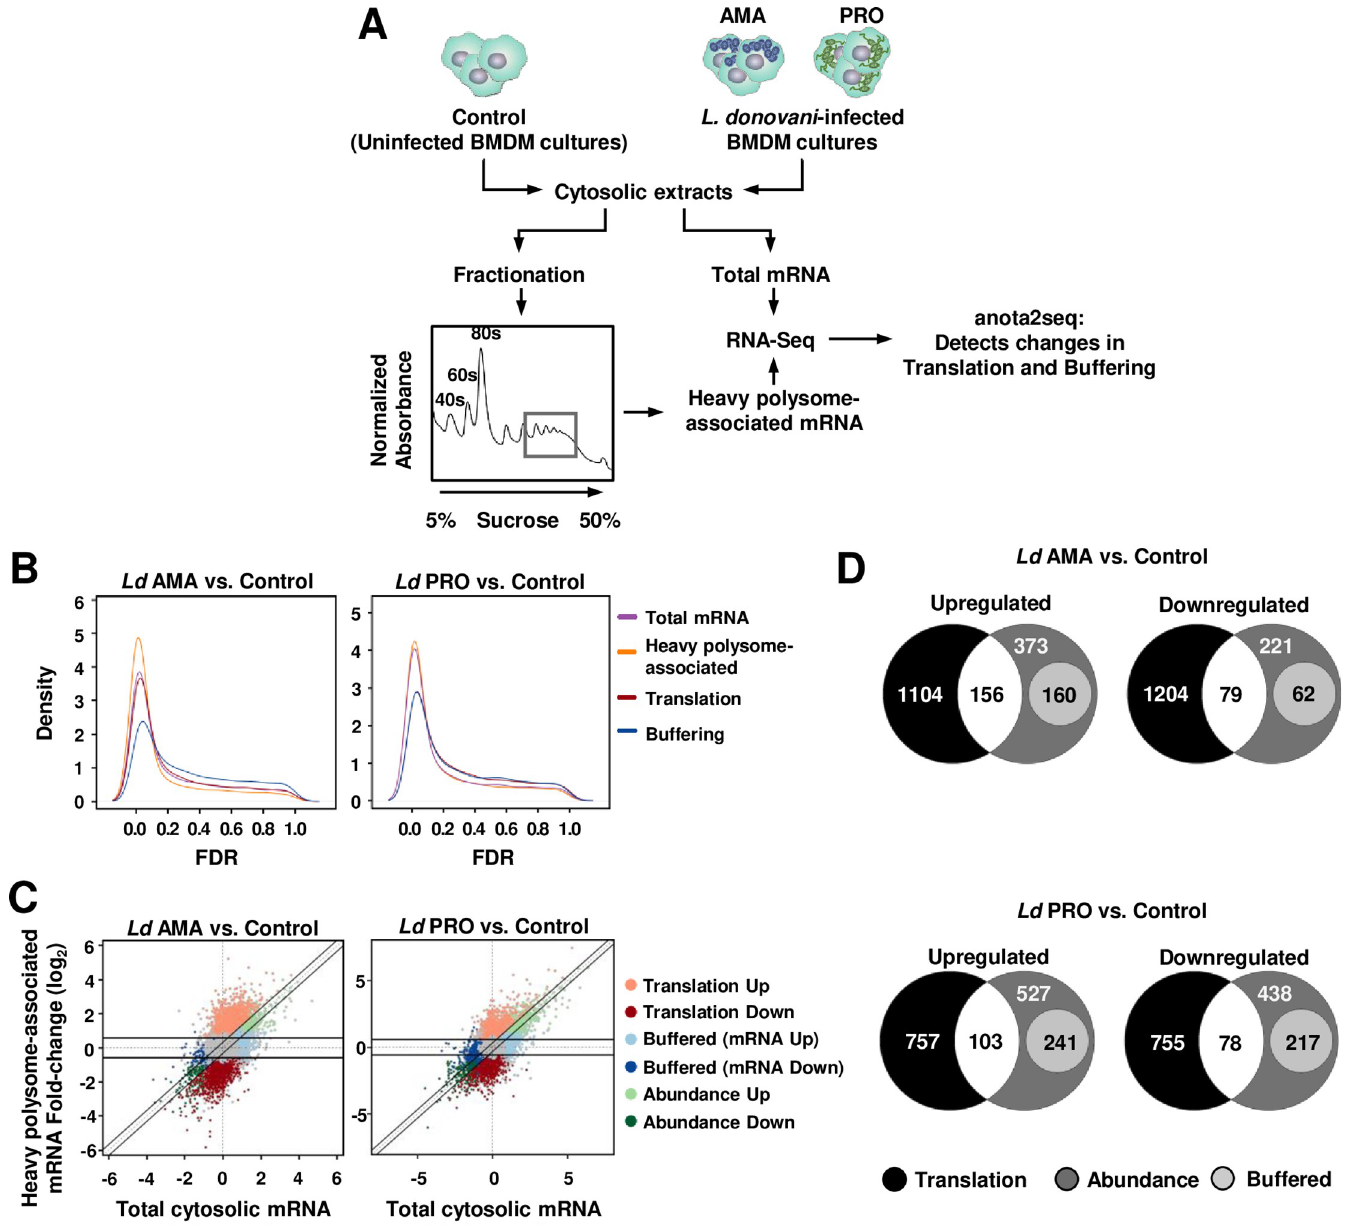
Fig 1. L . donovani infection causes widespread changes in mRNA translation in macrophages. ( A ) Strategy to characterize the translatome of L . donovani -infected BMDMs. ( B ) Kernel densities of adjusted p values (FDRs) following anota2seq analysis of changes in total mRNA, heavy polysome-associated mRNA, translation (i.e. changes in polysome-associated mRNA not paralleled by changes in total mRNA) and translational buffering (i.e. changes in total mRNA buffered at the level of translation) for BMDMs infected with L . donovani amastigotes ( Ld AMA) or promastigotes ( Ld PRO) compared to uninfected cells (Control). ( C ) Scatter plots of log 2 fold changes (for the same comparisons as in panel B) for heavy polysome-associated mRNA and total cytosolic mRNA. Differentially regulated transcripts through translation, abundance or buffering are indicated. Unchanged mRNAs are shown in grey. ( D ) Venn diagrams showing the number of mRNAs up- or down-regulated at the level of translation, abundance, and buffering for BMDMs infected with Ld AMA or Ld PRO compared to Control. ( B-D ) Data analyses were performed on samples generated from at least three biological replicates.